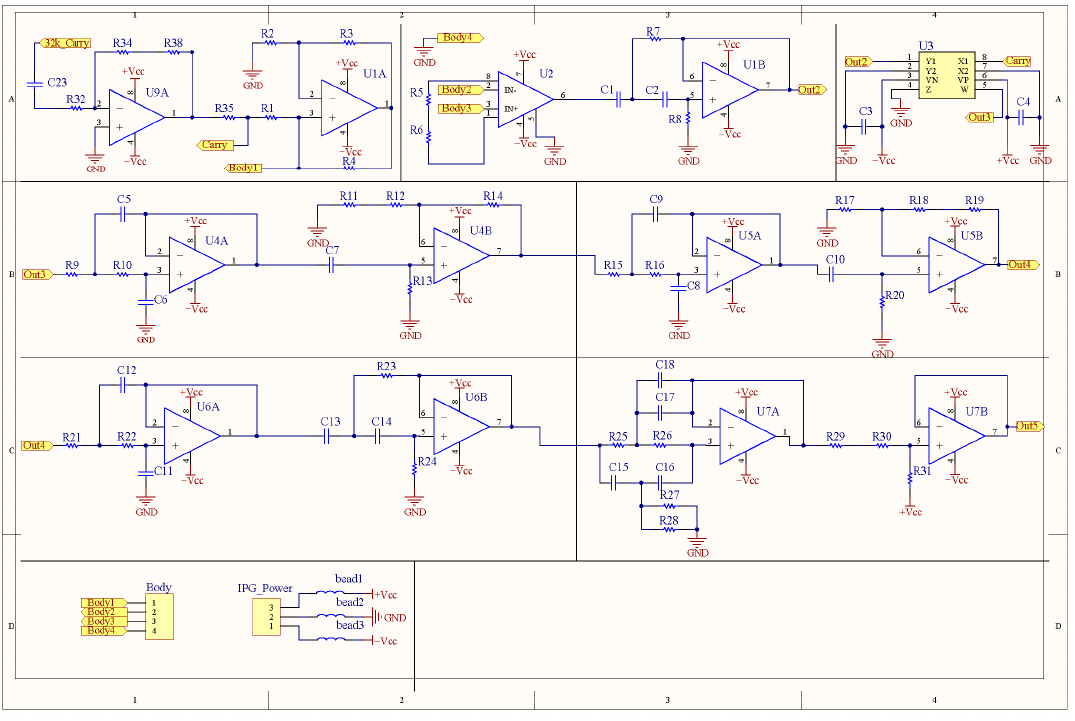
Figure 2. The circuit schematic of IPG measurement.